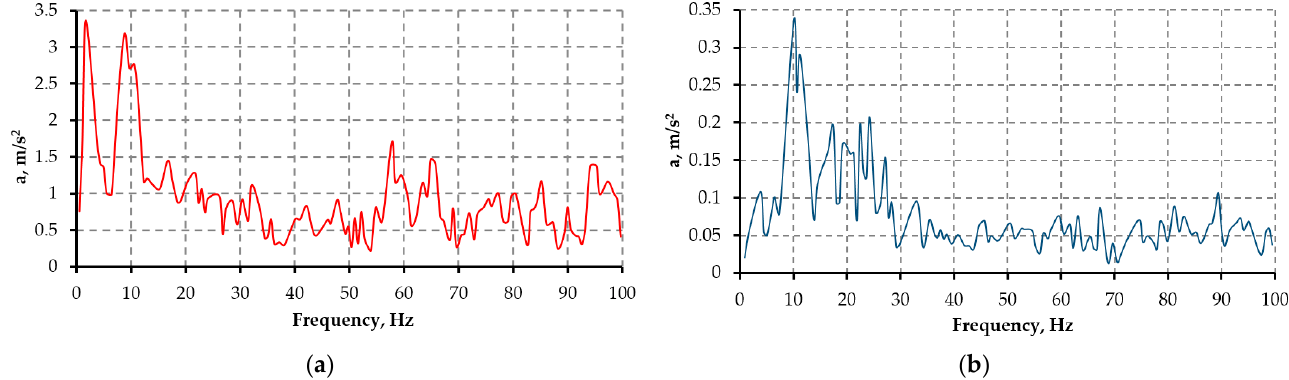
Figure 29. Frequency dependence of amplitudes of compact city, obtained by Fourier analysis: ( a )—front damped unsprung mass and ( b )—front damped sprung mass (city-type road, v = 70 km/h).